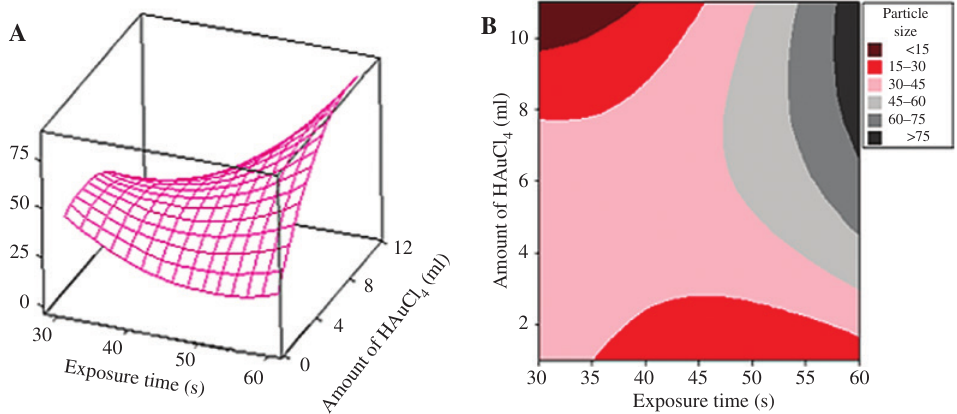
Figure 2: Response surface (A) and contour plots (B) for the mean particle size of produced AuNP solution as function of significant (p < 0.05) interaction effects of microwave exposure time and amount of HAuCl